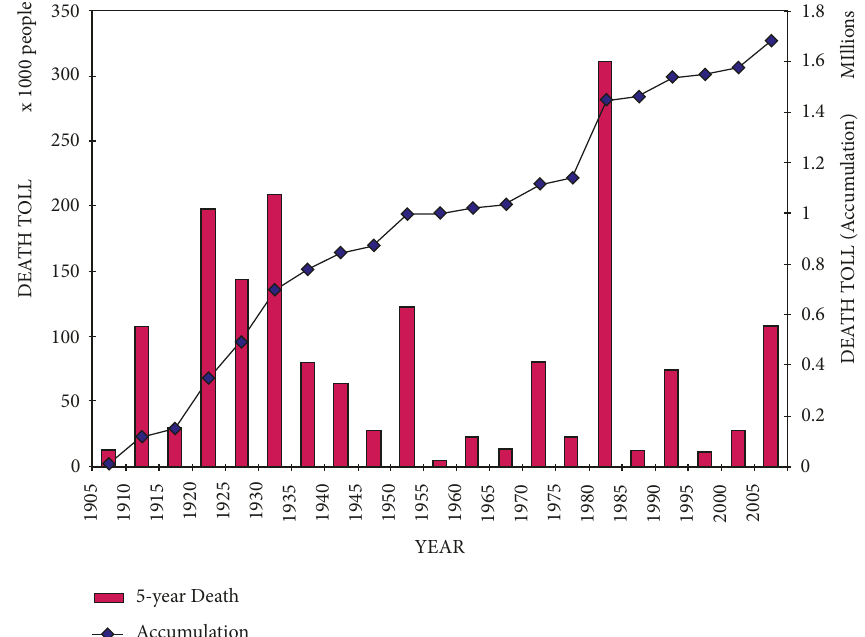
Figure 1: Loss of life caused by major earthquakes